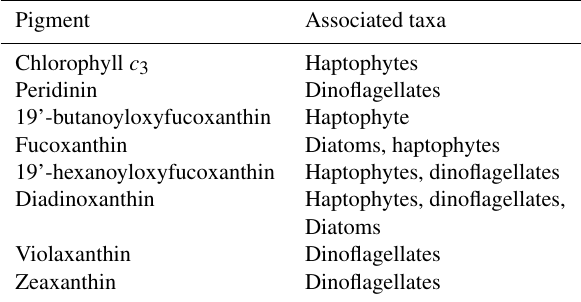
Table 1. HPLC marker pigments and their associated phytoplankton taxa. Adapted from Coupel et al.